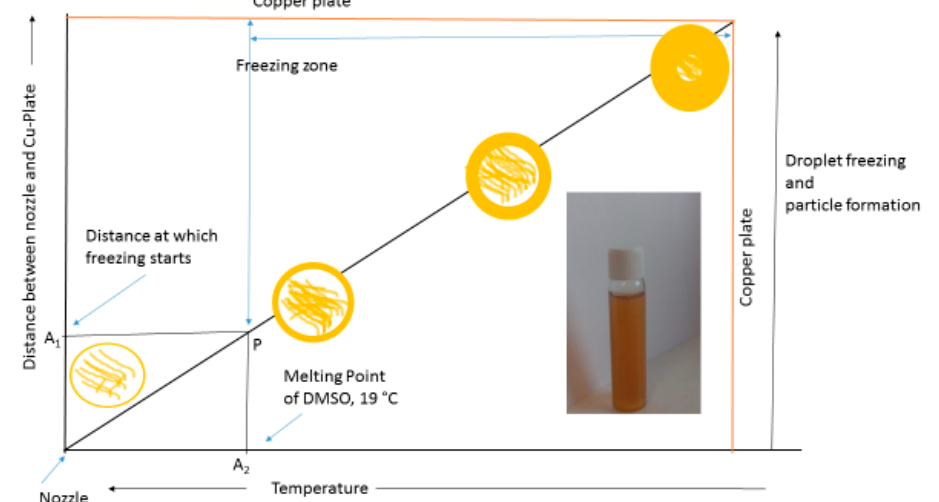
Figure 2. Graphical presentation of the method used and the mechanism of particle formation.